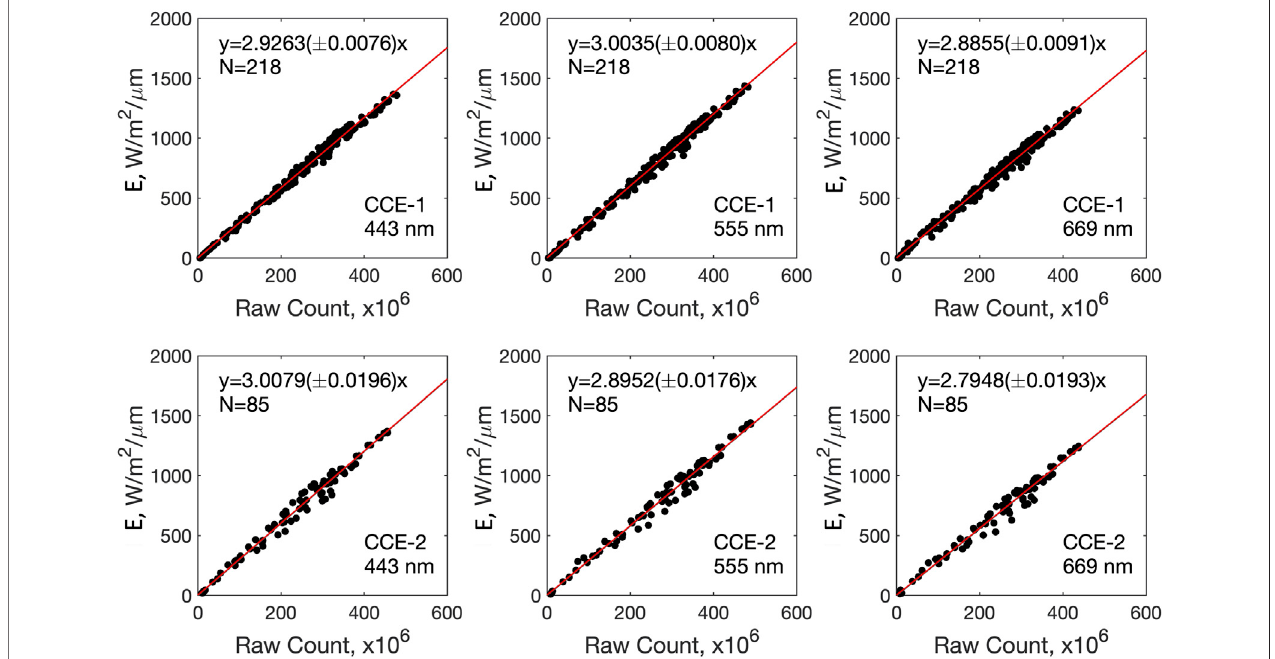
FIGURE 5 | Examples of derived calibration coef fi cients for CCE-1 (deployment #13) and CCE-2 (deployment #9) datasets at 443, 559, and 669 nm. Raw counts are compared with E simulation in conditions of clear sky with small aerosol optical thickness (see text for details).